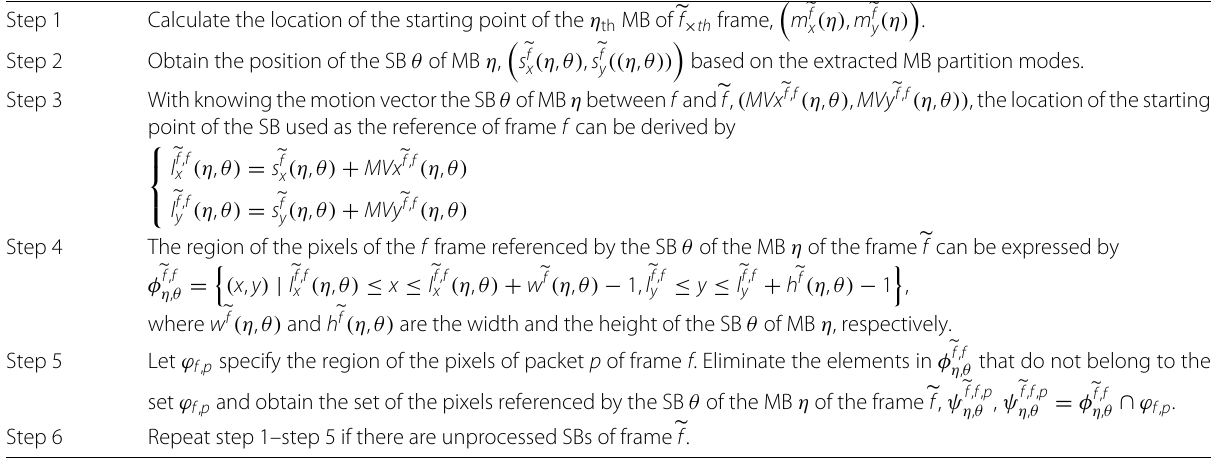
(cid:2) f , f , p η , θ